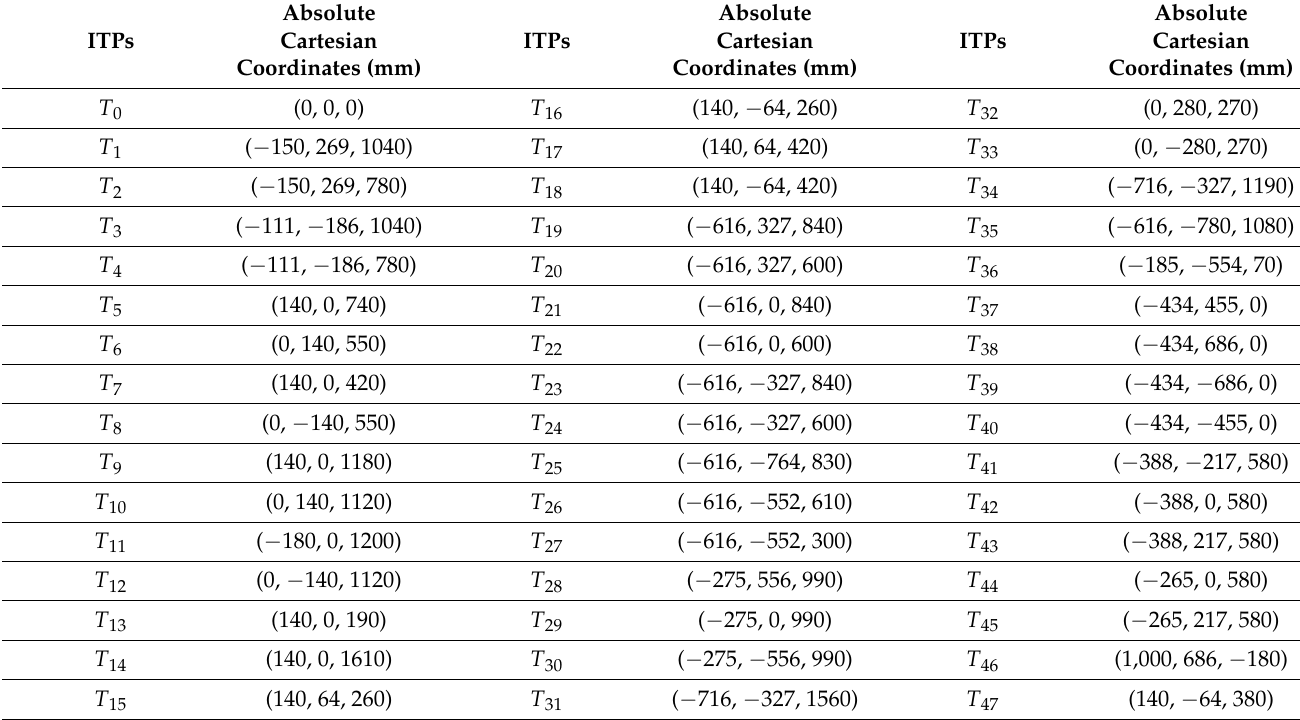
Table A2. The absolute Cartesian coordinates of all ITPs for experimental machine